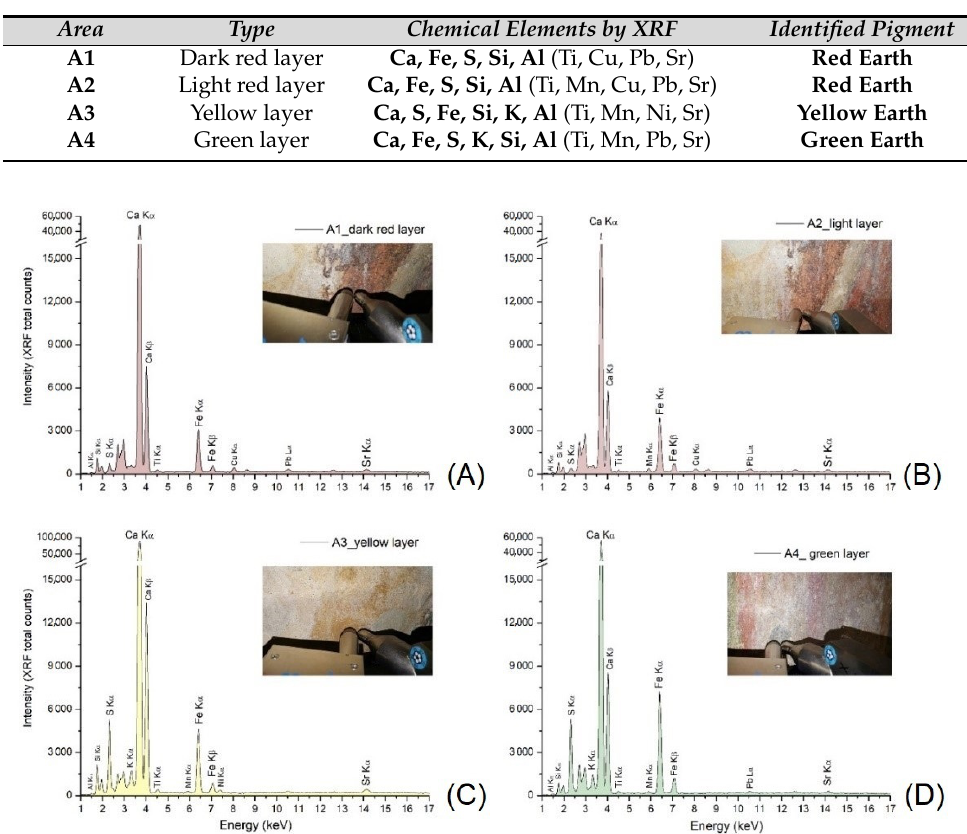
Table 2. Portable X-ray fluorescence (p-XRF) elemental composition of “Virgin” mural painting.